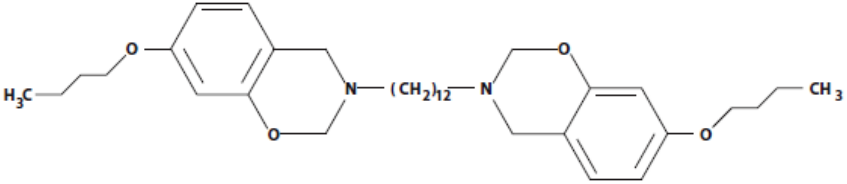
Figure 1. Molecular structure of 3BOP-daC12 benzoxazine monomer.